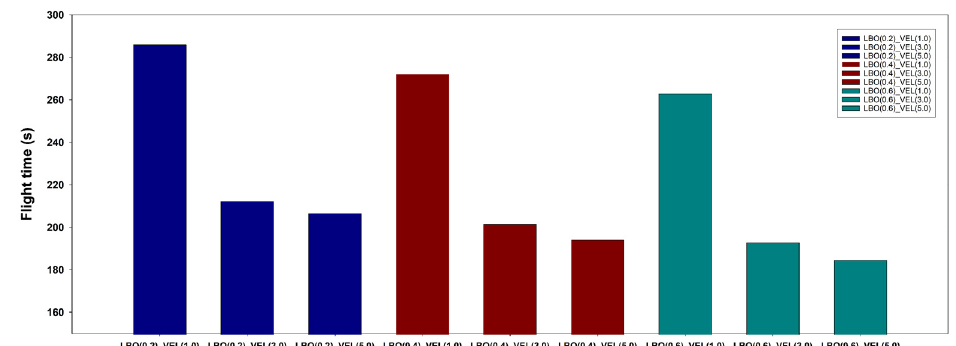
Figure 15. Total flight time by flight variable.